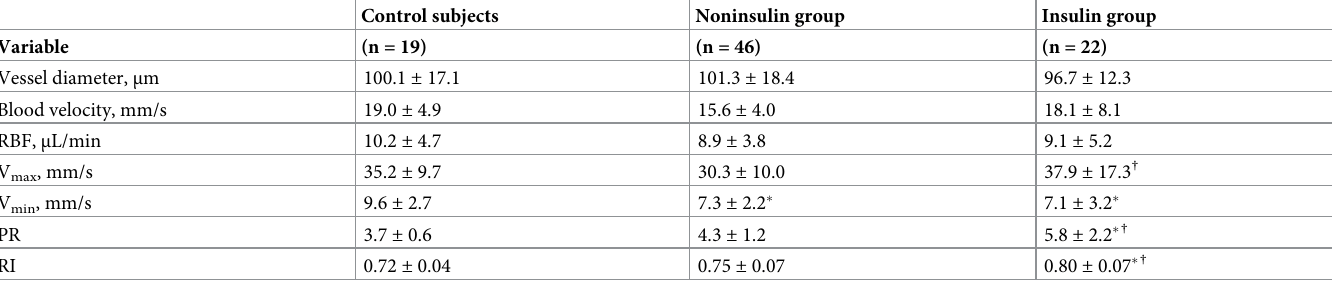
Table 4. Retinal circulatory parameters in control subjects and patients with or without insulin treatment.